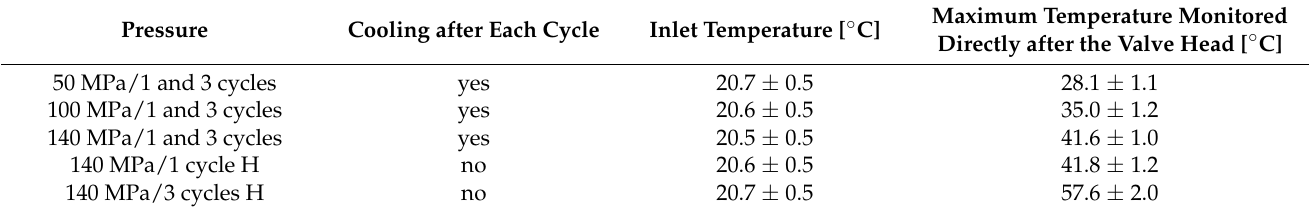
Table 1. Temperature changes during HPH processing, measured before